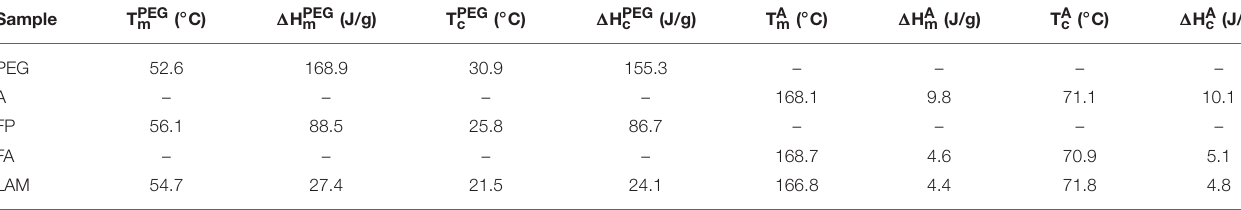
TABLE 4 | Results of the DSC tests on the prepared samples (first heating scan and cooling scan).